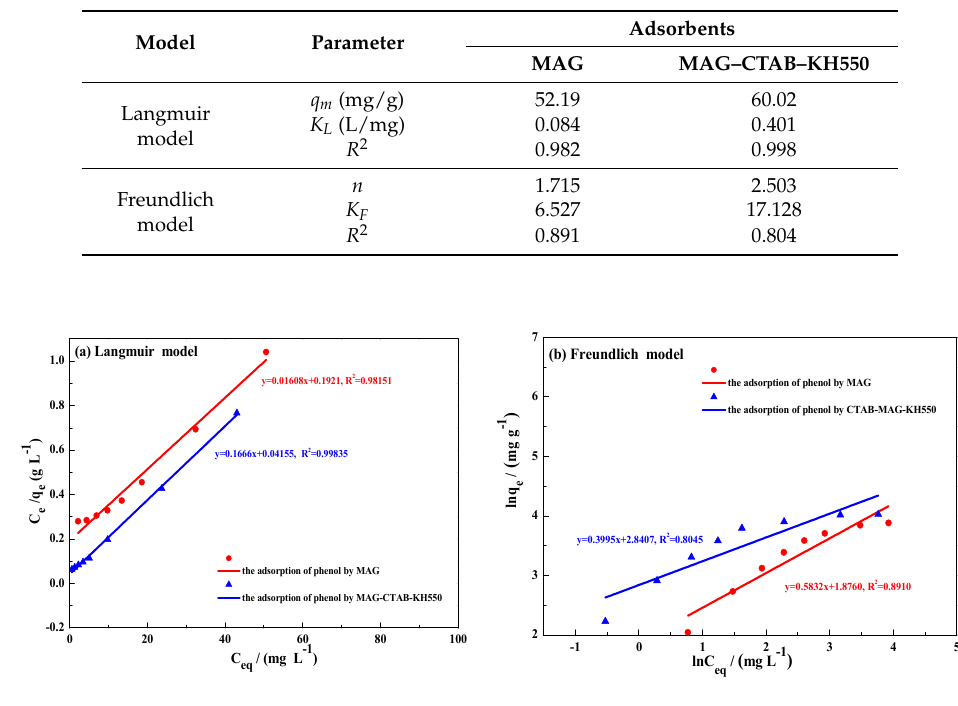
Figure 8. Adsorption isotherm models ( a ) Langmuir model and ( b ) Freundlich model.